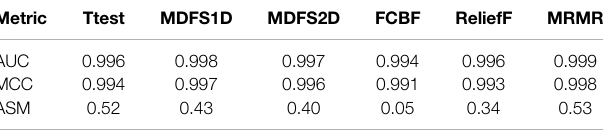
TABLE 1 | Comparison of feature selection